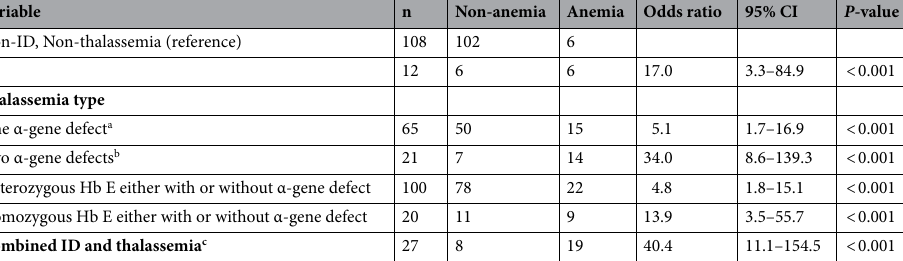
Table 4. Logistic regression analysis for anemia among subjects inhabiting at the border region of Thailand, Lao PDR and Cambodia. a Including heterozygous α + -thalassemia (− α 3.7 ), heterozygous α + -thalassemia (− α 4.2 ), heterozygous Hb CS, heterozygous Hb PS. b Including homozygous α + -thalassemia (− α 3.7 ), compound heterozygous α + -thalassemia (− α 3.7 )/Hb CS, compound heterozygous α + -thalassemia (− α 3.7 )/Hb PS, heterozygous α 0 -thalassemia (– SEA ). c Including heterozygous α + -thalassemia (− α 3.7 ), heterozygous α + - thalassemia (− α 4.2 ), heterozygous Hb CS, compound heterozygous α + -thalassemia (− α 3.7 )/Hb CS, heterozygous α 0 -thalassemia (– SEA ), heterozygous Hb E either with or without α-gene defect, homozygous Hb E either with or without α-gene